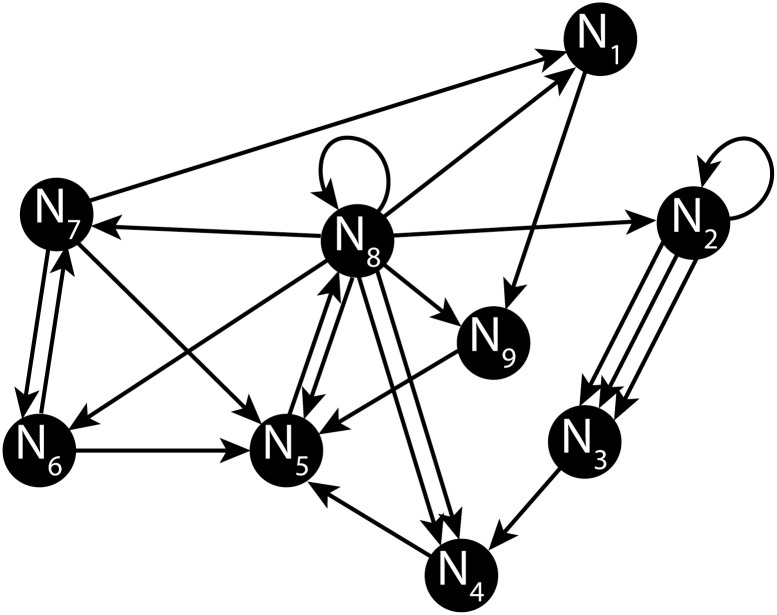
Example model network.An example network with N = 9 nodes and directional edges connecting them in a ‘Directed Graph’ with directionality corresponding to flow of neuronal excitation. Note some edges are self-loops (e.g., Node 2 and 8), and multiple-connects exist between others (e.g., Node 2 and Node 3). This is therefore not a ‘simple’ graph since it includes auto- and multiple-connections.